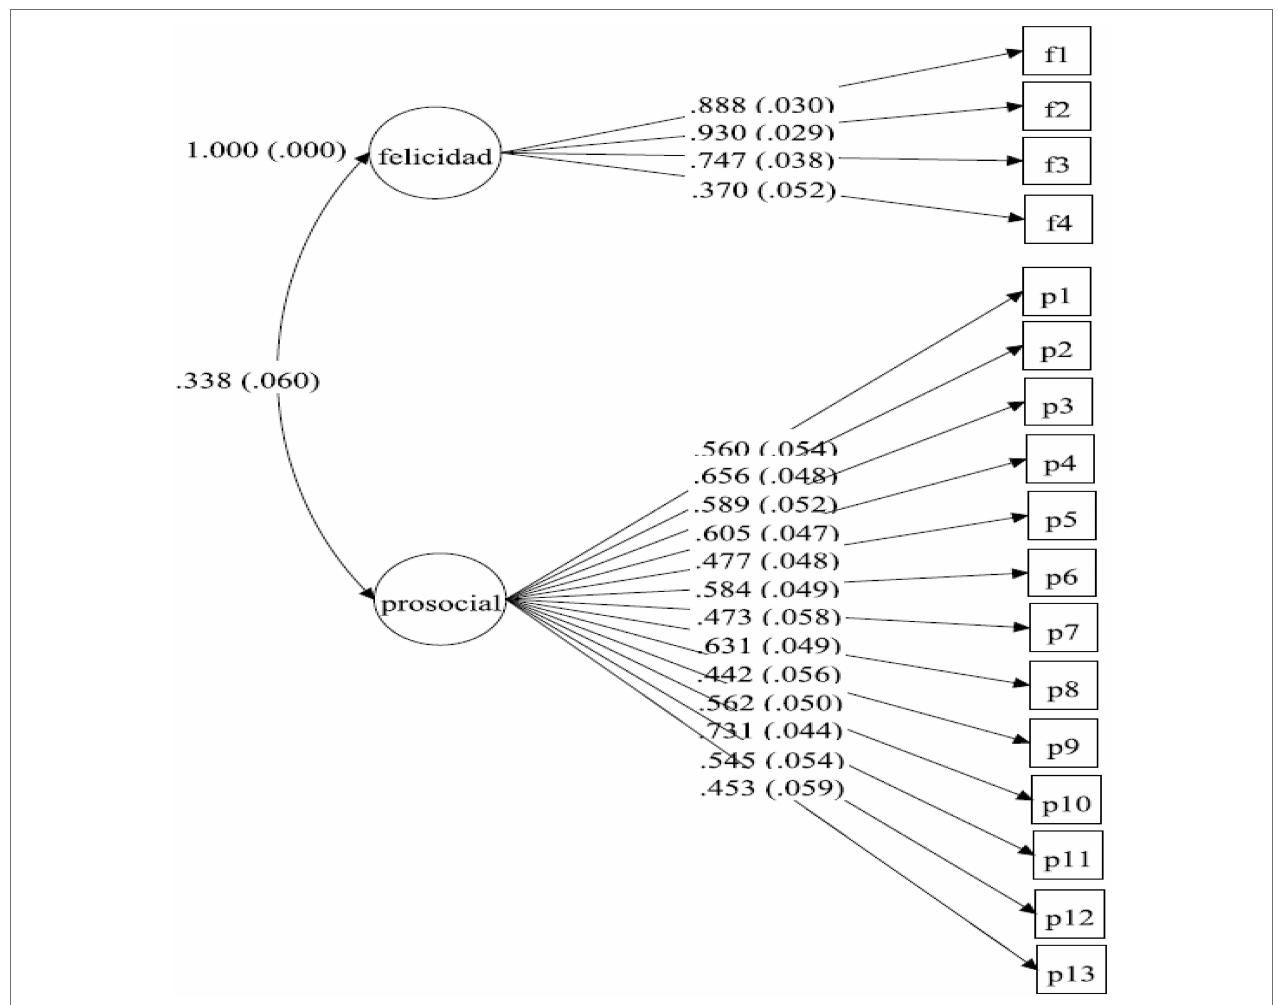
FIGURE 1 | Standardized results of the CFA applied to the model created by the authors with the support of Mplus 7.11 (Muthén and Muthén,